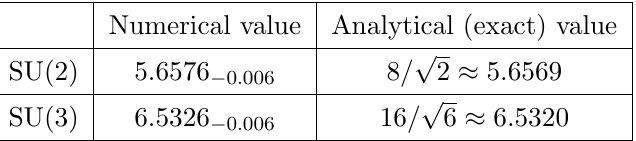
Table 2 . SU(2) & SU(3) numerical and analytical half k -string